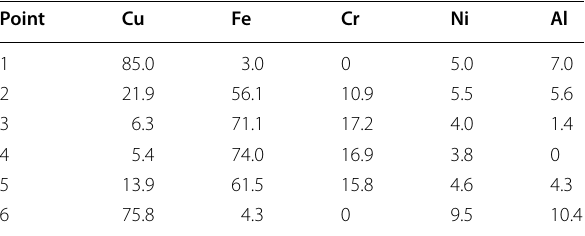
Table 3 Element contents of cladding micro-zone (mass fraction,